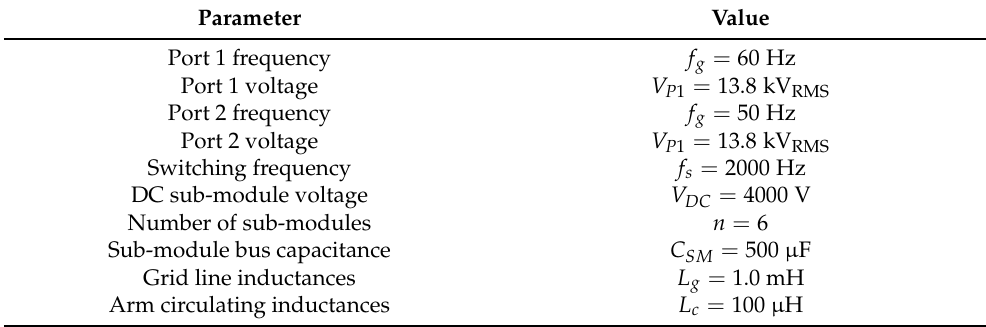
Table 1. Converter parameters